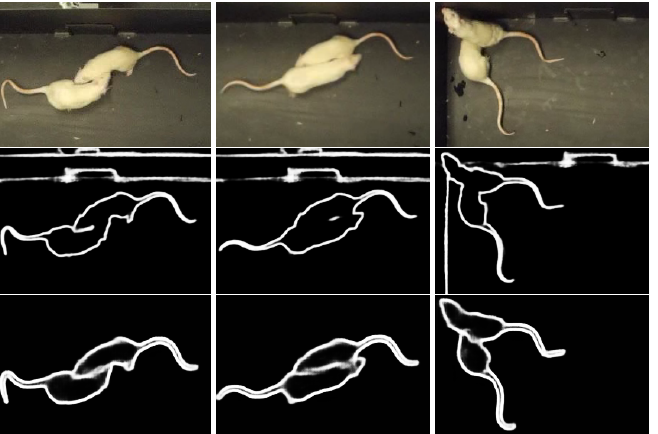
Figure 10. Edge detection results. ( Top row ): three different RGB frames. ( Middle row ): corre- sponding edge detection with BIPED DexiNed. ( Bottom row ): our Edge Detection results, with S EPA R ATS model. Our Edge Detection predicts well-defined grayscale edges in the inner sections of the boundaries that can be thresholded.